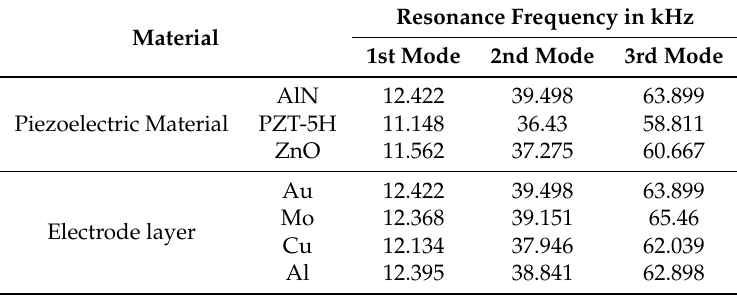
Table 2. Simulation results using initial parameters for different piezoelectric material and electrode layer, the first mode result for different materials is in close range with respect to desired